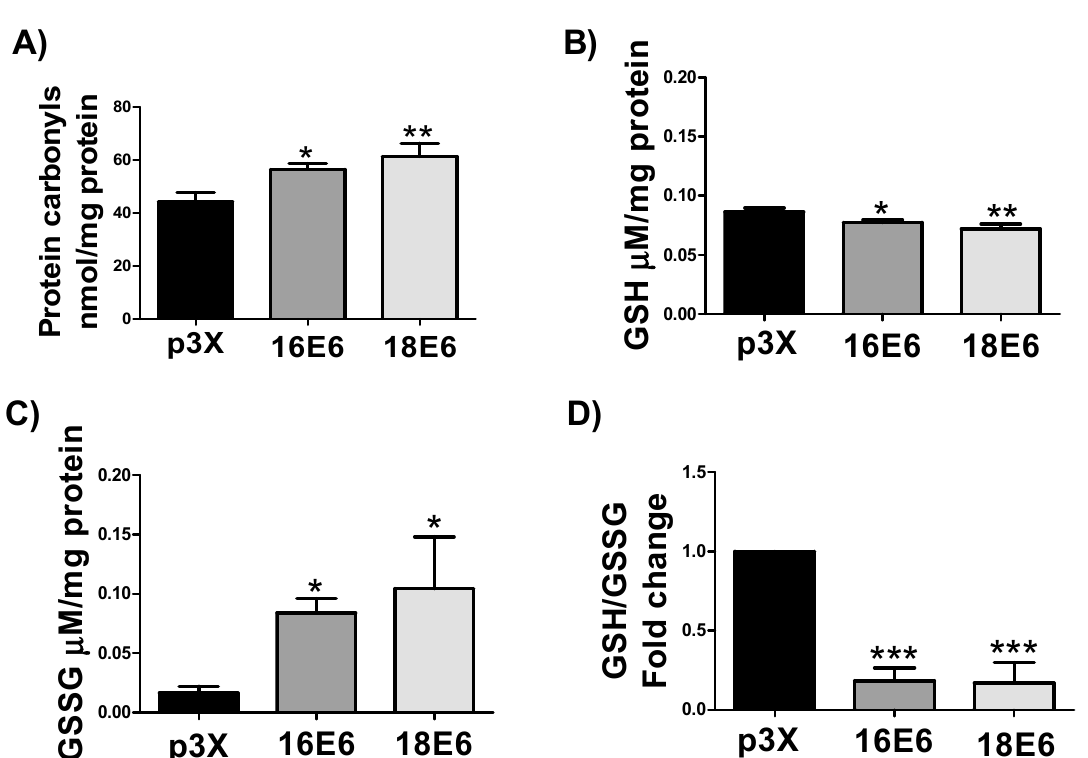
Figure 7. E6 oncoproteins from HPV16 and HPV18 promote oxidative stress in FaDu cells. ( A ) protein carbonyls; ( B ) GSH levels; ( C ) GSSG; and, ( D ) GSH / GSSG ratio, in comparison with the control vector. Protein carbonyls, GSH, and GSSG levels are expressed as the mean ± SD. Tukey’s test * p < 0.05, ** p < 0.005 and *** p < 0.0005.